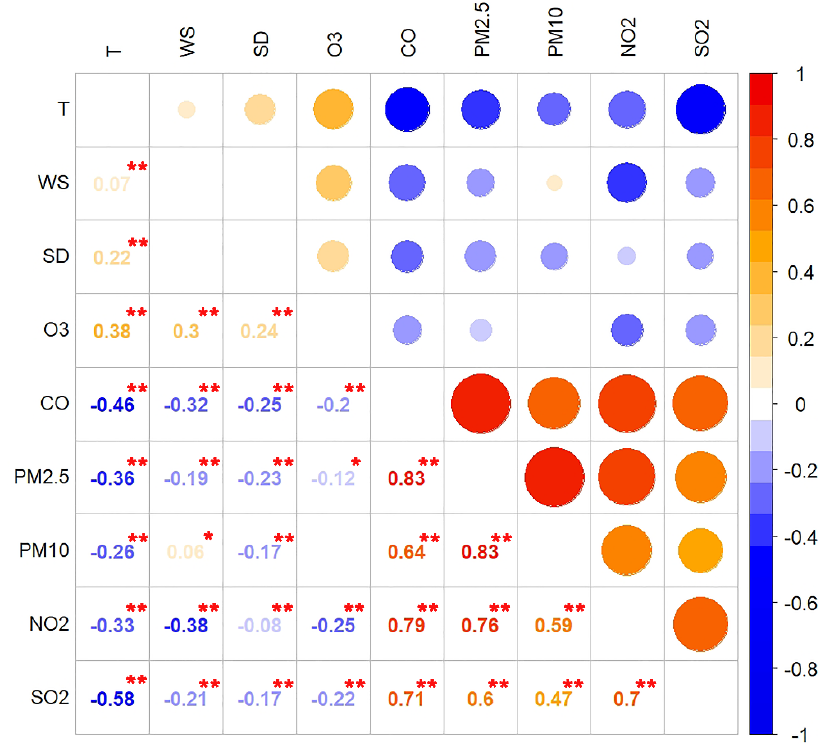
Figure 8. Correlation coefficients between O 3 and meteorological elements/other pollutants. (* * indicates that the correlation is significant at level 0.01 (double tail). * indicates that the correlation is significant at level 0.05 (double tail)).